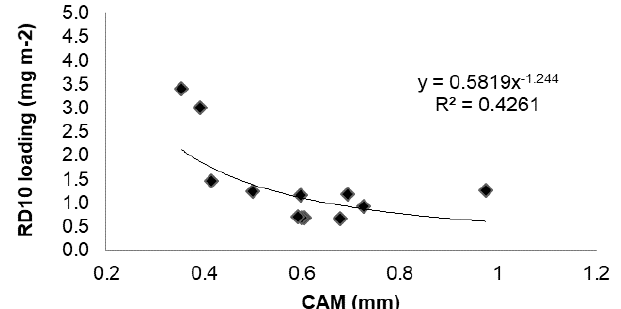
Figure 7. Relationships between RD10 loading and pavement corrected aggregate median (CAM).